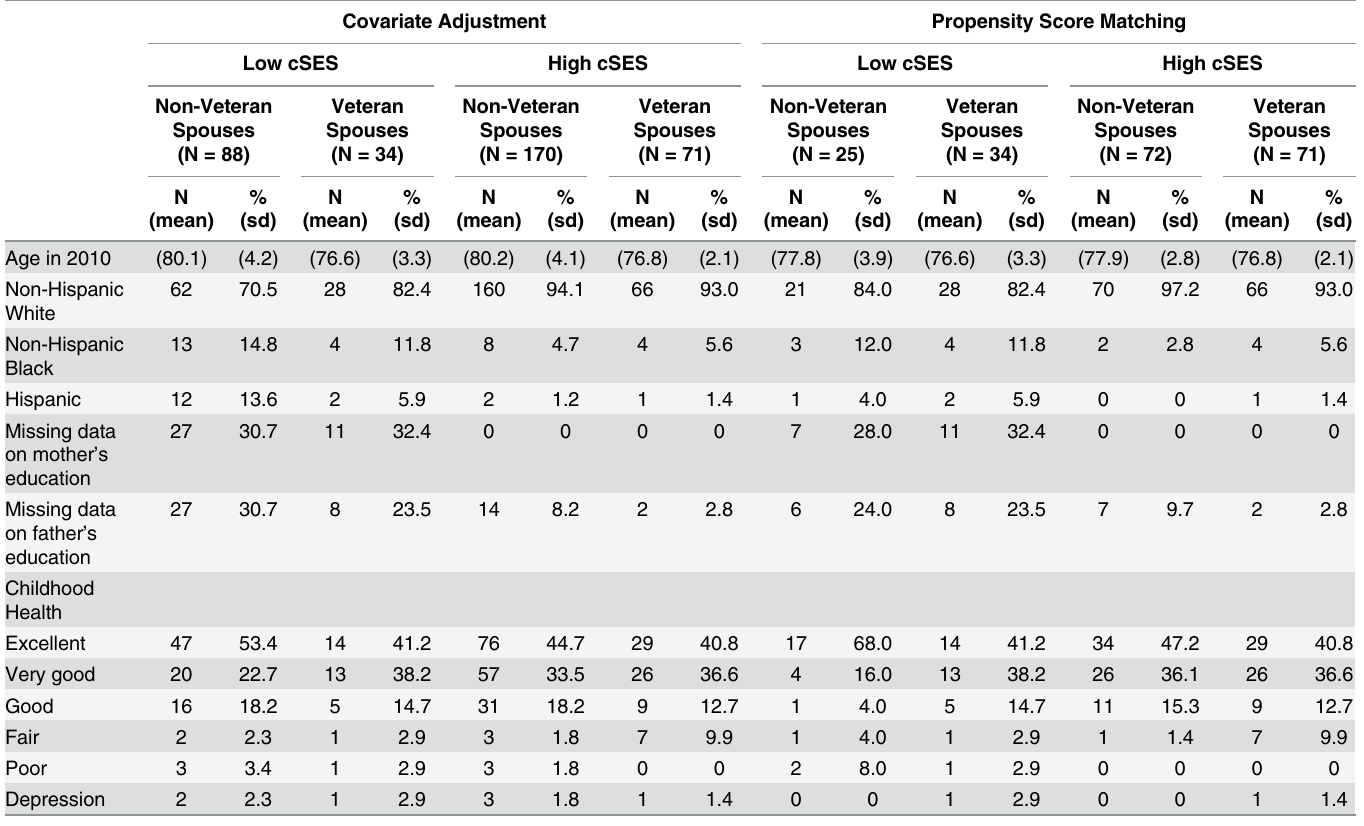
Table 7. Distribution of covariates in the CA and PSM analytic